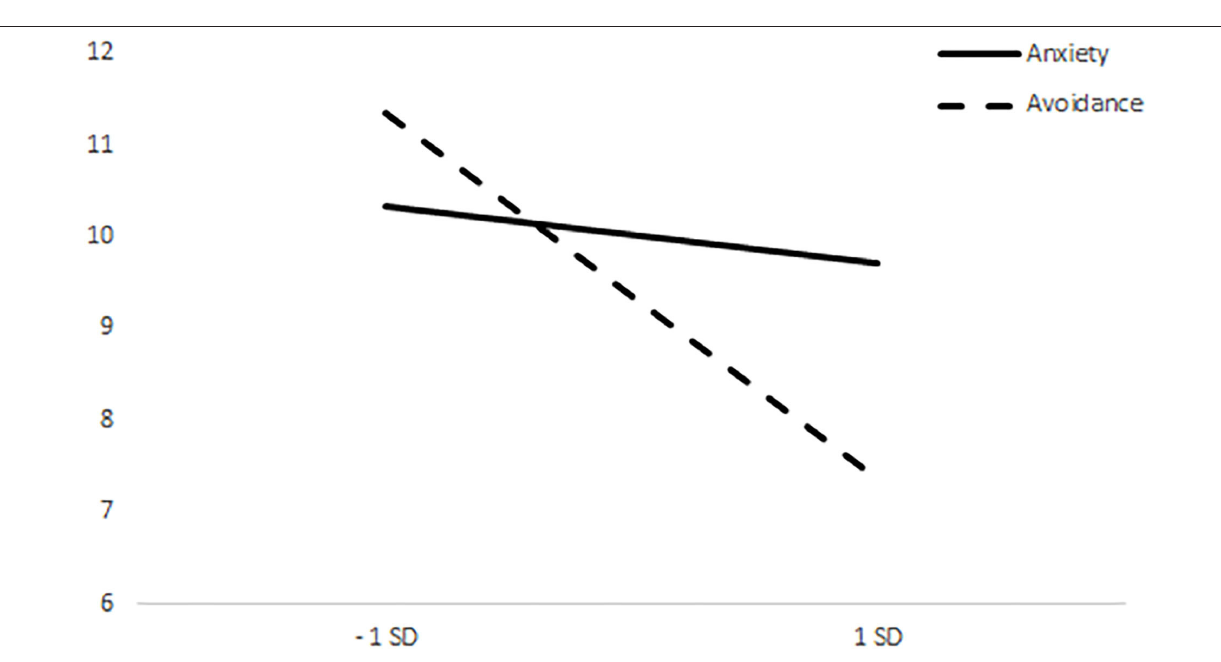
FIGURE 3 | Differences between means of care pictures choices in the neutral